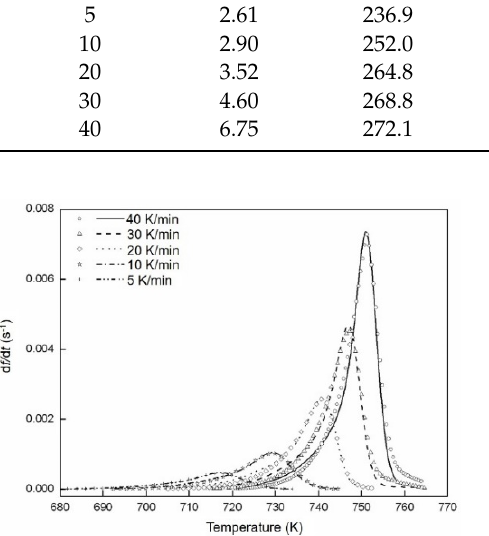
Figure 6. The evolution of the overall effective activation energy Q and the Avrami (growth) expo- nent n with heating rates of 5–40 K min − 1 . The separate activation energy for nucleation and growth is obtained by fitting Equation (6) to the data points with n and Q values listed in Table 1. The result is Q N = 297 ± 10 kJ mol − 1 , Q G = 204 ± 33 kJ mol − 1 , with an R-square value of about 0.79.